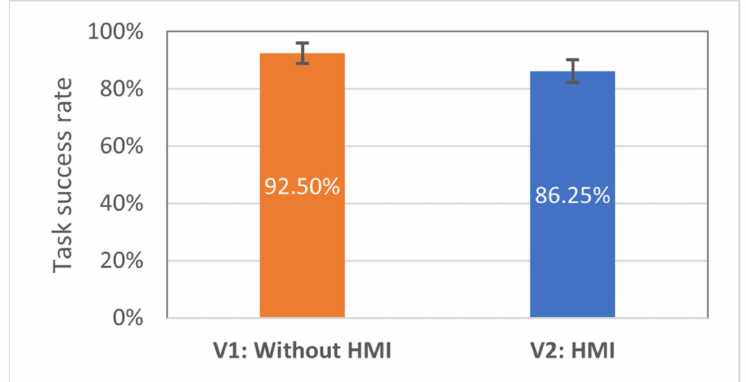
Figure 16. Average task success rate for all 16 participants: higher is better.